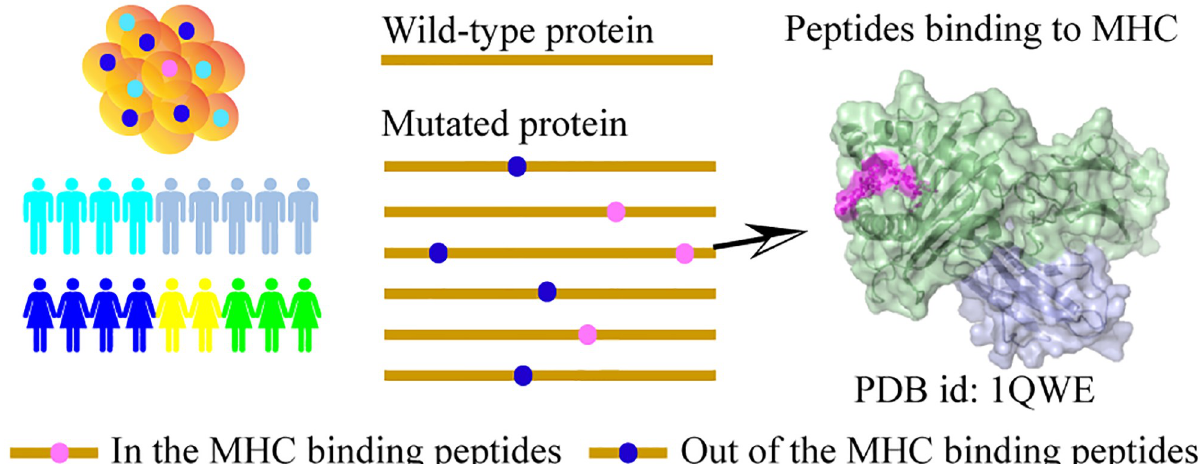
Fig 5. Predicting MHC-binding peptides and calculating mutation densities. Mutations within the MHC binding peptides are shown in blue dots, and mutations out of the MHC binding peptides are shown in pink dots. Protein sequence are shown as yellow line.